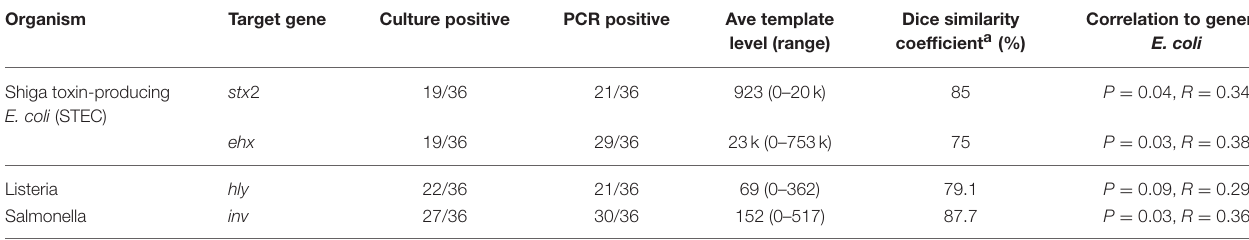
TABLE 5 | Quantification of environmental pathogens in Moore swabs by ddPCR.